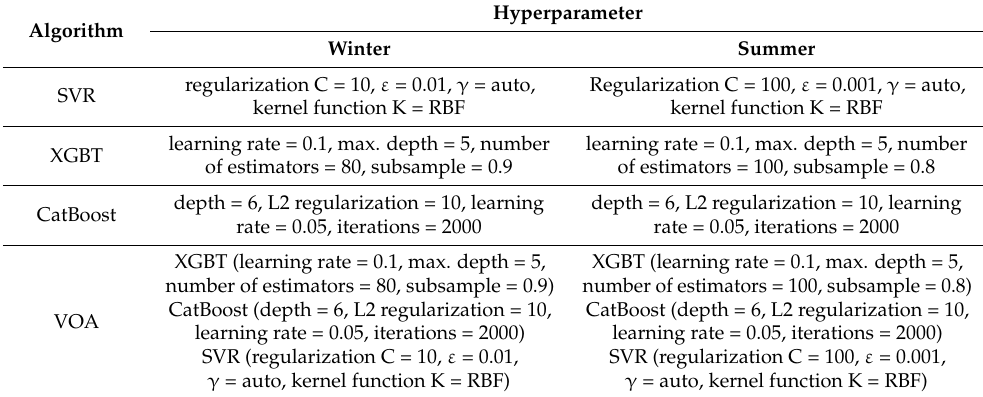
Table 4. Algorithm hyperparameter tuning.